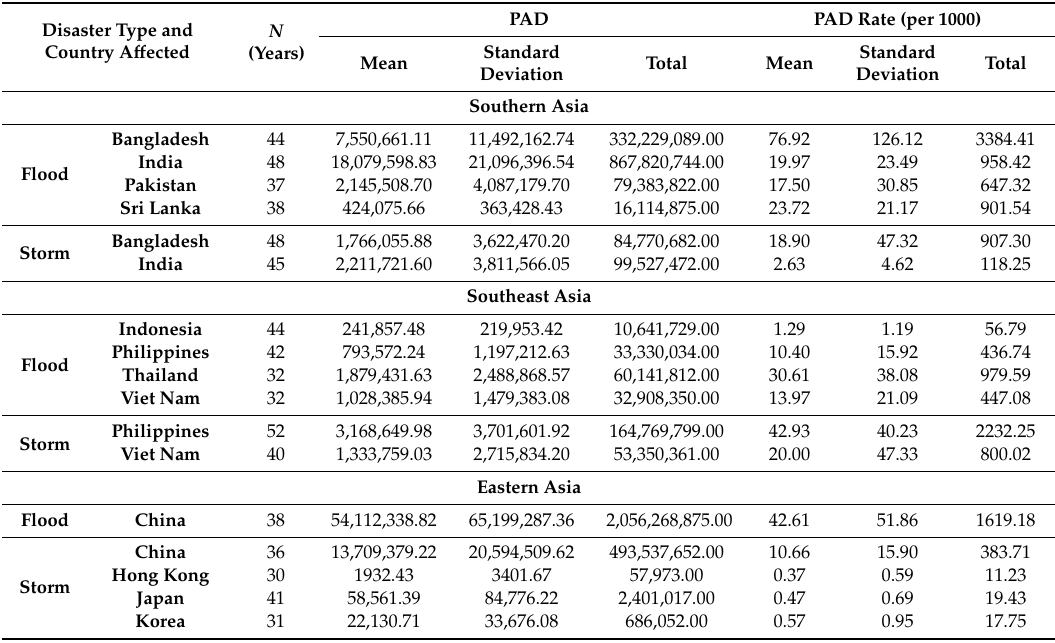
Table A1. Descriptive statistics of the total number of people a ff ected by natural disaster (PAD) and PAD rate (per 1000) by type and country / city with disaster events reported in not less than 30. Yearly data from EMDAT data,